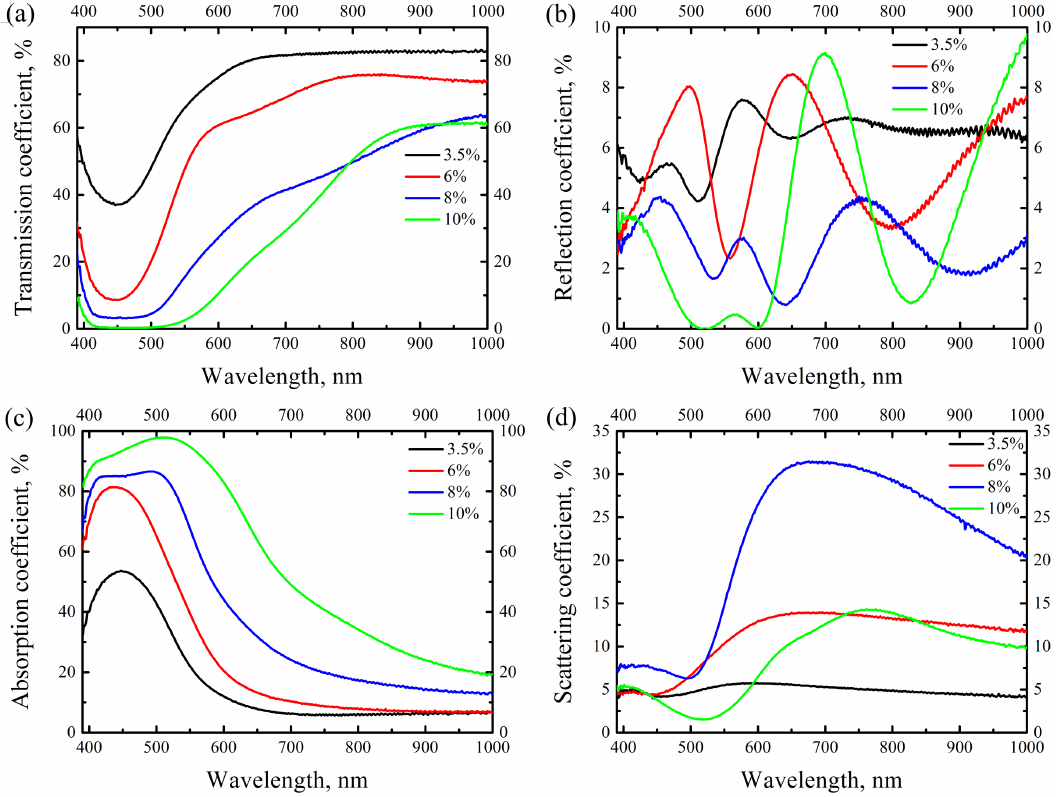
Figure 5. The dependences of the coefficients of ( a ) transmission, ( b ) reflection, ( c ) absorption, and ( d ) scattering for the PPX+Ag coatings with the different volume concentrations of silver (3.5%, 6%, 8%, 10%) at normal